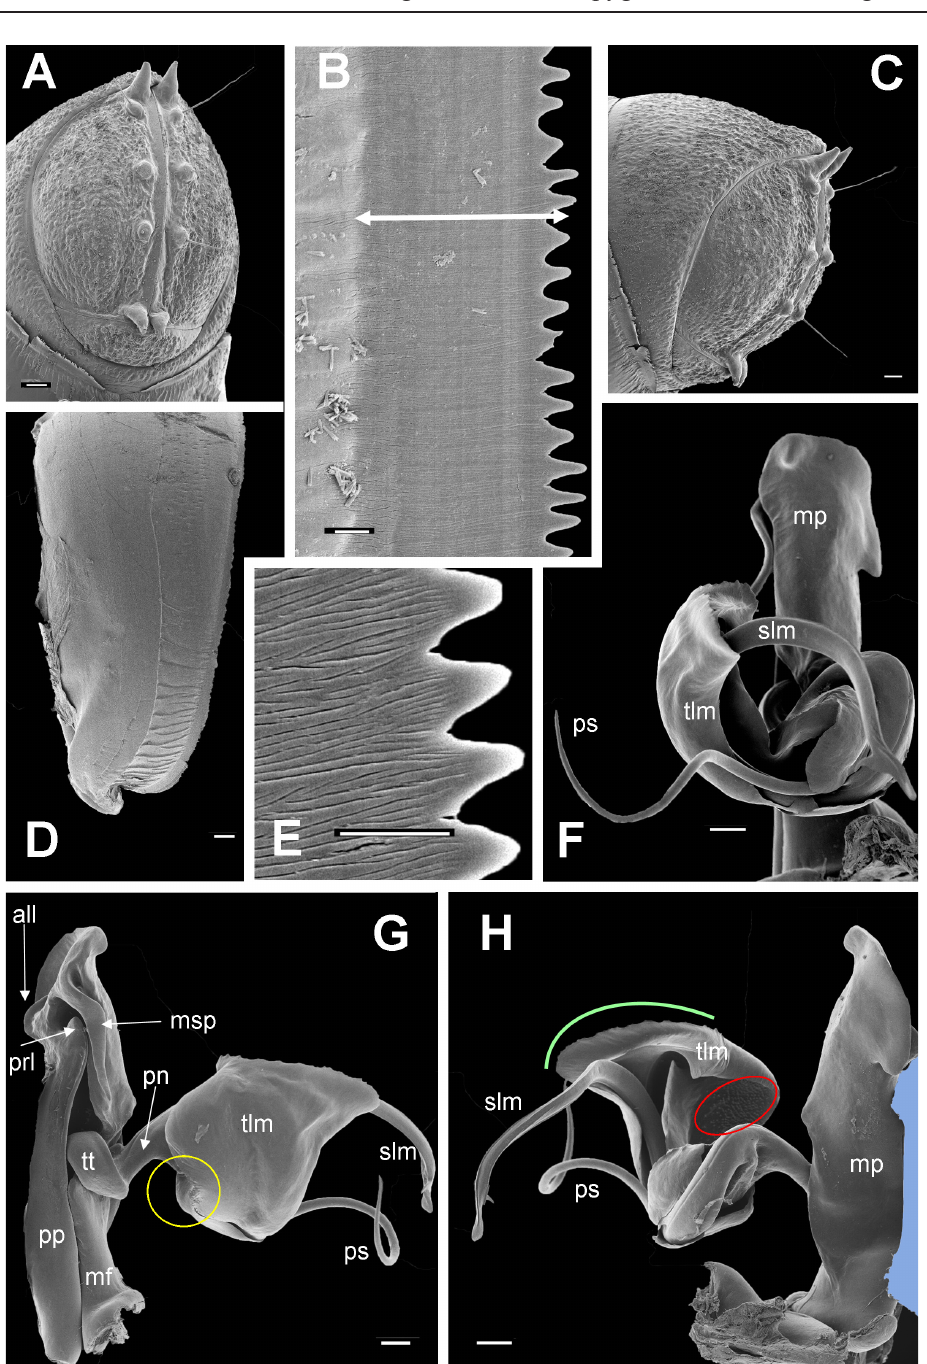
Fig. 3. Casuariverpa scarpa gen. et sp. nov. , paratype from Udzungwa Scarp Forest Reserve above Chita village. A, C . Telson. A. Posterior view. C. Lateral view. B . Limbus, the double-headed arrow indicates the extent of the limbus. D . Body ring 7, left lateral view. E . Detail of limbus to show microstriolation. F–G . Left gonopod. F. Mesal view. G. Anterior view, the yellow circle indicates the position of the microspinose field shown in Fig. 4E. H . Posterior view, the red oval indicates the position of the microspinose field shown in Fig. 4E, the green line indicates the distal margin of the telomere; blue colour = mounting tape. Abbreviations: all = apical lateral lobe of coxa, mf = metaplical flange, mp = metaplica, msp = metaplical spine, pn = post-torsal narrowing, pp = proplica, prl = proplical lobe, ps = proximal solenomeral spine, slm = solenomere, tlm = telomere, tt = torsotope. Scales: A, C–D, F–H = 0.1 mm; B, E = 0.01